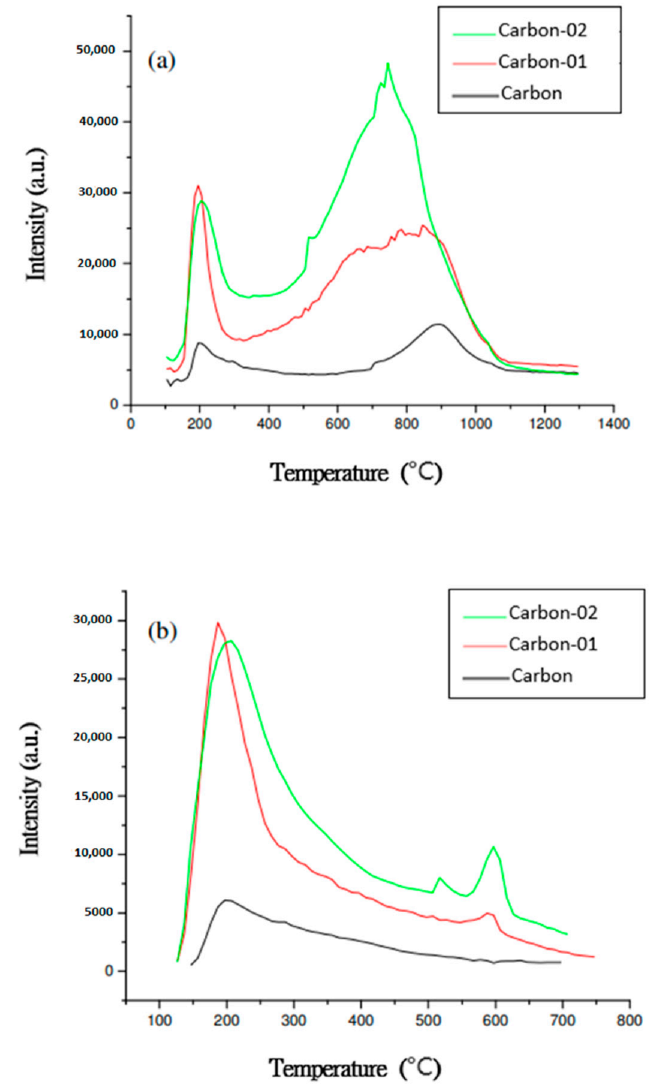
Figure 1. TPD profile of CO and CO 2 on ( a ) CO desorption, ( b ) CO 2 desorption. Table 2. Modification condition of carbon black and their pore